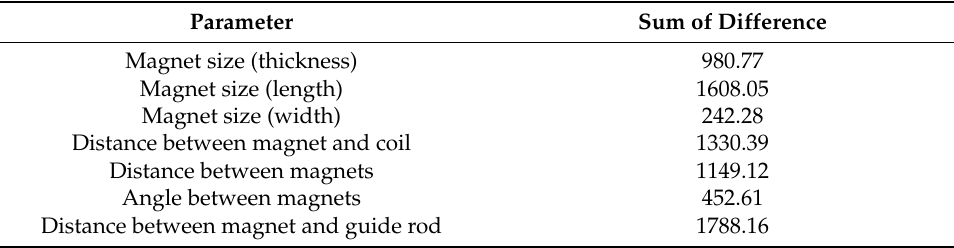
Table 10. Total variation of retention force difference under each